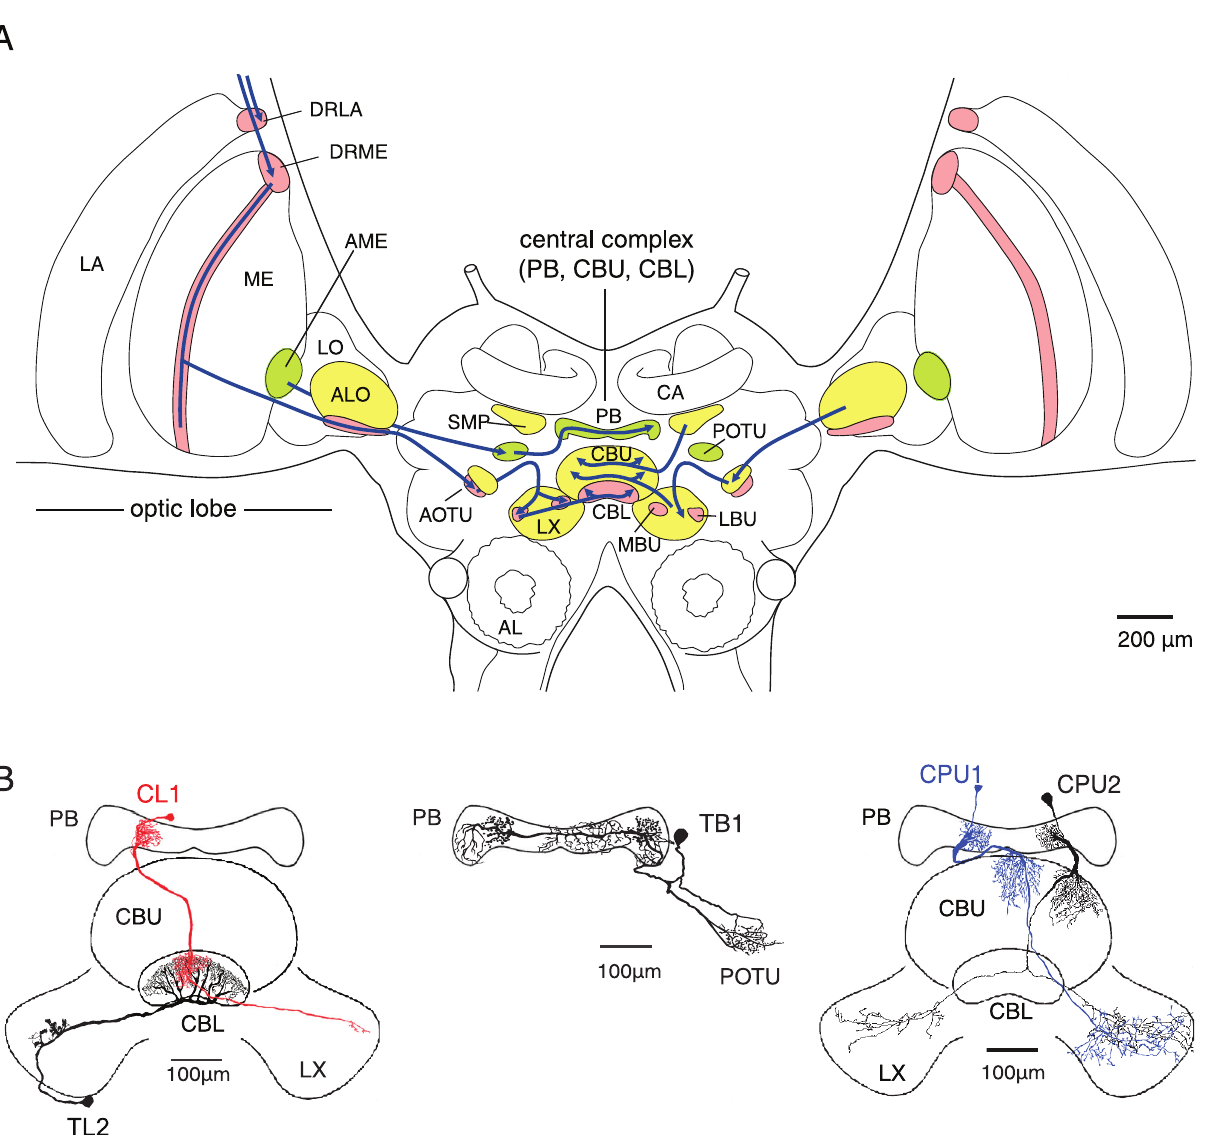
Fig 1. Gross anatomy of the locust brain, visual pathways, and relevant types of central complex neurons. A. Bilateral pathways of light-sensitive neurons from the optic lobes converge onto a network in the central complex (frontal view). Stages of early visual processing include the lamina (LA), medulla (ME) and lobula (LO) of the optic lobe. Neuropils shaded red (green) are involved in an anterior (posterior) pathway of interneurons sensitive to sky compass signals. Additional pathways (yellow neuropils) might signal optic flow and / or represent features of the visual object-background scenery. DRLA (DRME), dorsal rim area of the lamina (medulla); ALO, anterior lobe of the lobula; AME, accessory medulla; AOTU, anterior optic tubercle; POTU, posterior optic tubercle; MBU (LBU) medial (lateral) bulb; LAL, lateral accessory lobe; together with the LAL, the MBU and LBU make up the lateral complex (LX). CBL (CBU) lower (upper) division of the central body; PB, protocerebral bridge; SMP, superior medial protocerebrum; CA, calyx of mushroom body. B. Relevant cell types of the central complex (frontal view). Tangential neurons invade all slices of the CBL (TL neurons) or some slices in the PB (TB1 neurons), as well as regions in a lateral complex (TL) or layers in a POTU (TB). Columnar neurons connect distinct slices of the PB to the CBU (CPU neurons) or CBL (CL neurons) of the central body and have additional arborizations in the lateral complexes. Scale bar, 100 μ